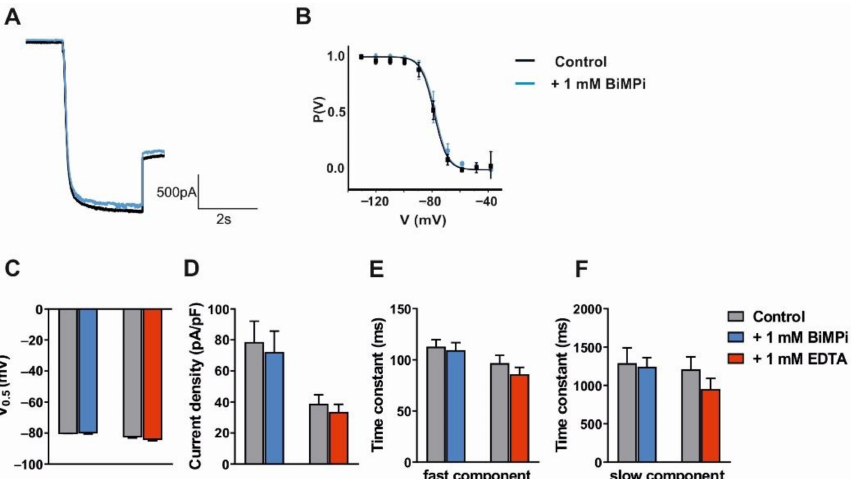
Figure 6. The effects of divalent cation chelators on I h current recorded in HEK293 cells expressing mHCN2 channels. ( A ) Exemplary traces of I h current recorded in HEK293 cells in control condition (black) and in the presence of 1 mM BiMPi (blue). For clarity, only the hyperpolarizing step from − 40 mV to − 130 mV is shown. ( B ) The mean steady-state activation curve for control and BiMPi recordings after plotting normalized tail current amplitudes against the step potential and fitting them to a Boltzmann function. ( C – F ) The bar graphs comparing the HCN2 channel V 0.5 ( C ), I h current density ( D ), fast ( E ) and slow ( F ) component of HCN channel activation under control and experimental conditions (as indicated by color-coding). Table 4. The effects of divalent cation chelators on I h current in HEK293 cells. Data are given as mean ± SEM. The control measurement and corresponding substance effect were recorded from the same cell. BiMPi 1 mM EDTA 1 mM Ctrl BiMPi n Ctrl EDTA